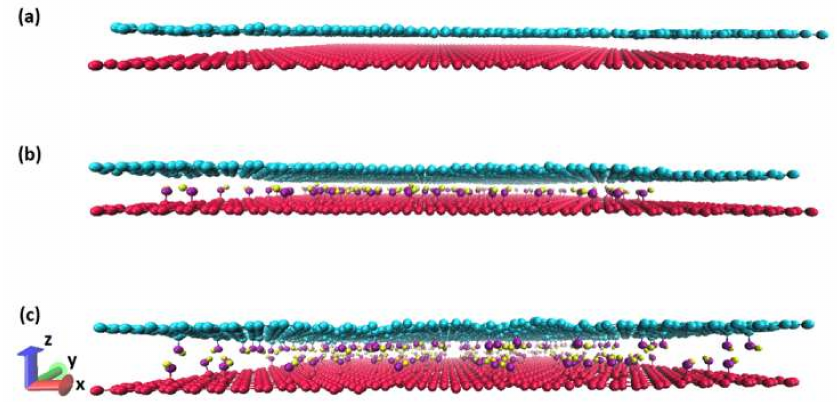
Figure 1. The structures of simulation models ( a – c ). Blue, red, purple and yellow balls denote C atoms in the upper graphene layer, C atoms in the lower graphene layer, O atoms and H atoms, respectively. In model ( b ) and ( c ), the hydroxyl groups ratio on graphene layers is 0%/5% and 5%/5%